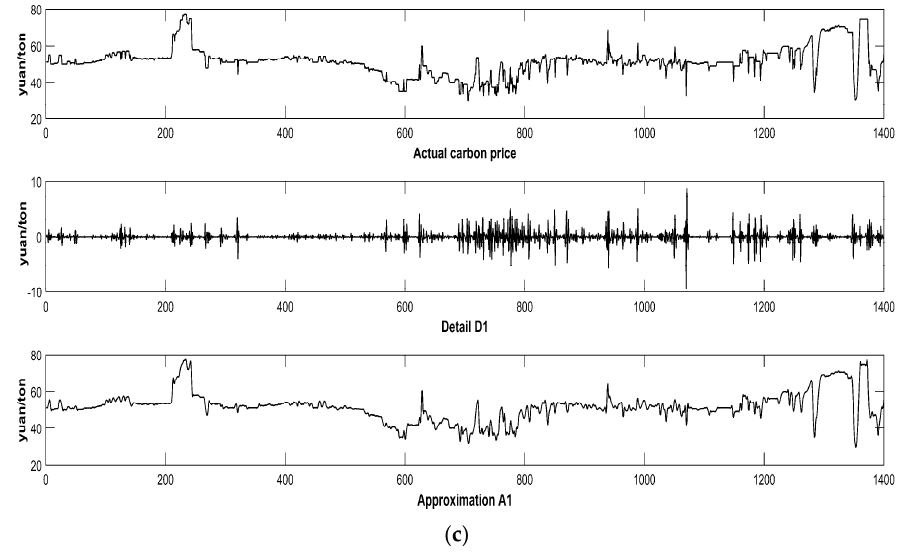
Figure A3. ( a ) The FEEMD decomposition result of the Beijing carbon price; ( b ) The EMD decomposition result; ( c ) The WT decomposition result. Table A9. The results of SE values under various decomposition methods.